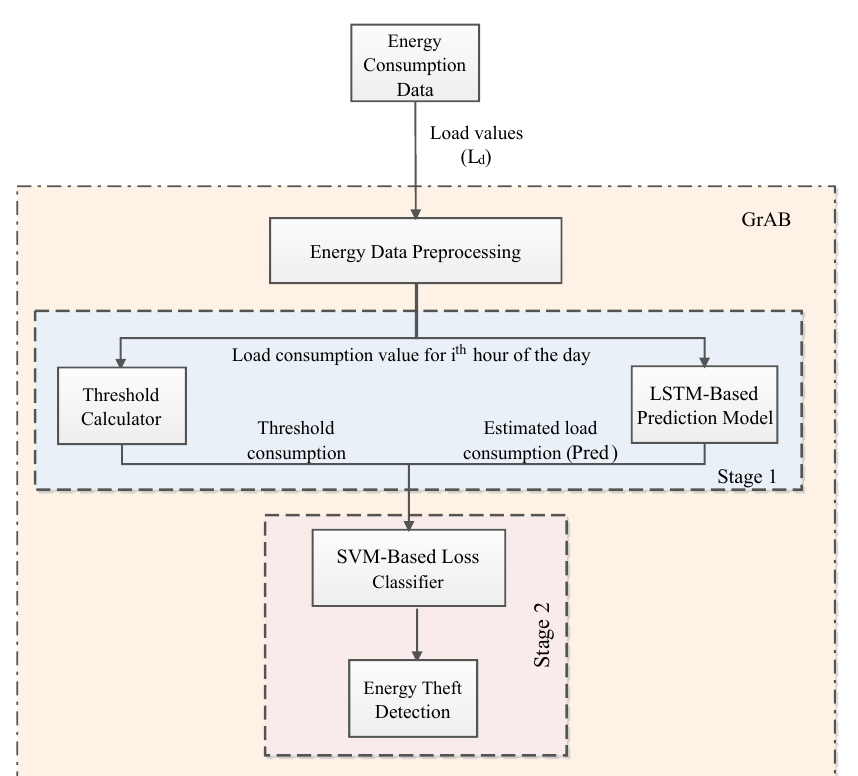
Figure 3. GrAb System